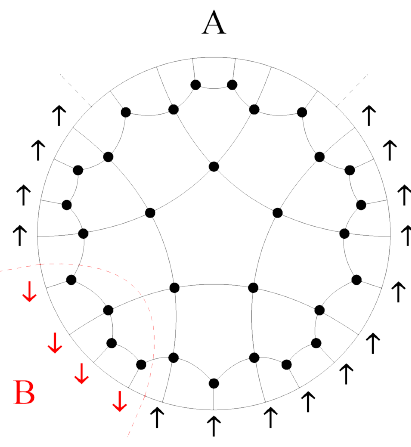
Figure 21 . Schematic plot of a hyperbolic random tensor network. Each vertex (black dots) in the bulk denotes a random tensor | V . These tensors are fused together along the internal edges of x i the graph by projecting onto maximally-entangled EPR pairs; the remaining unfused legs define a holographic state on the boundary. Averaging over the Haar ensemble at each vertex yields an effective statistical mechanics model with a discrete classical variable located at each vertex. Under this mapping, calculating entanglement entropies in the original tensor network corresponds to computing free energies in the corresponding statistical mechanics model, subject to certain boundary conditions imposed at the holographic boundary. For example, to compute the 2nd Renyi entropy of a region B , we map to a classical Ising model with − 1 boundary conditions in the region B (red spins) and +1 in the remaining boundary (black spins). Performing local projective measurements on a region A of the boundary corresponds to imposing open boundary conditions. Note that the complement of A ∪ B is C